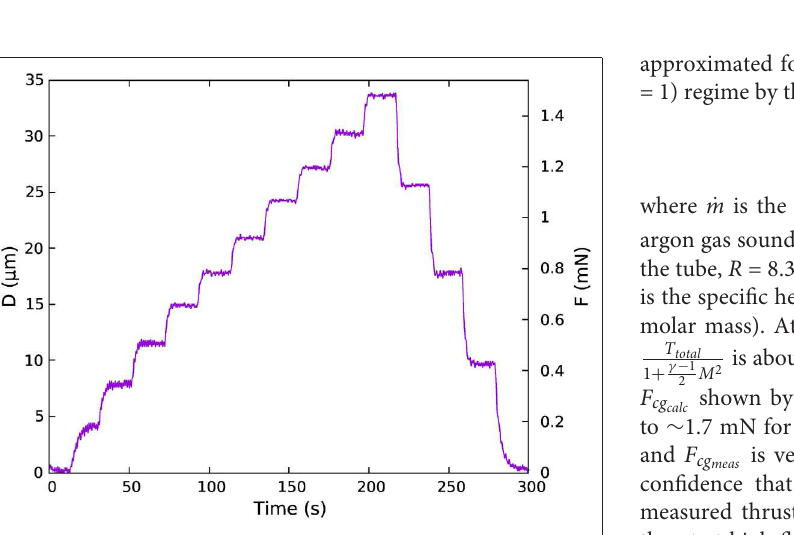
FIGURE 6 | Raw data from thrust balance showing balance displacement D over time. In this sequence, the thruster was operated with cold gas starting at 0 to 200 SCCM in steps of 20 SCCM, then return back to 0 SCCM in steps of 50 SCCM. Each step lasts for 20 s. The data sampling rate is 312.5 Hz with a moving average of 256 applied. It is then reduced by taking the mean of every 16 measurements. The basic calibration is measured to be approximately 0.044 mN/ µ